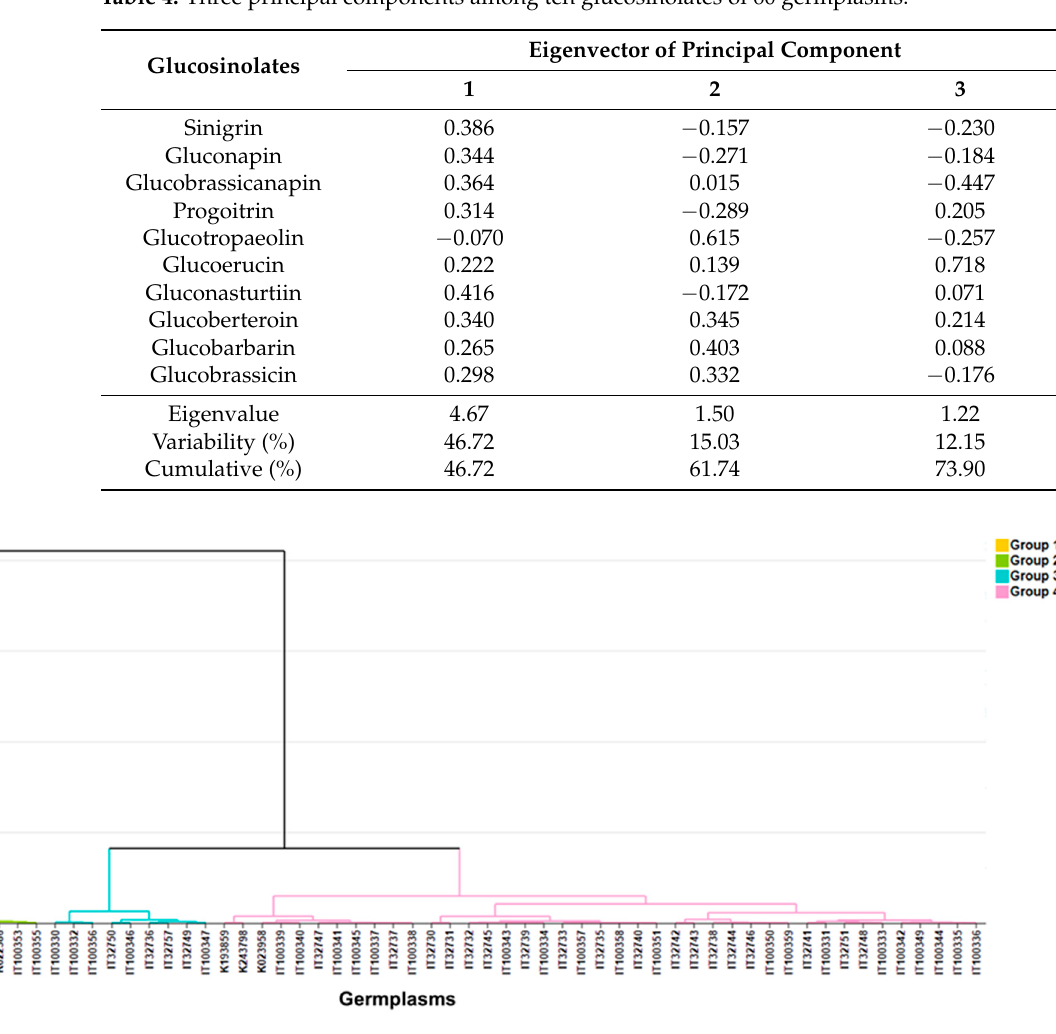
Figure 4. Dendrogram from results of the k-means clustering. The four cluster groups are indicated by yellow, green, blue, and pink colors.